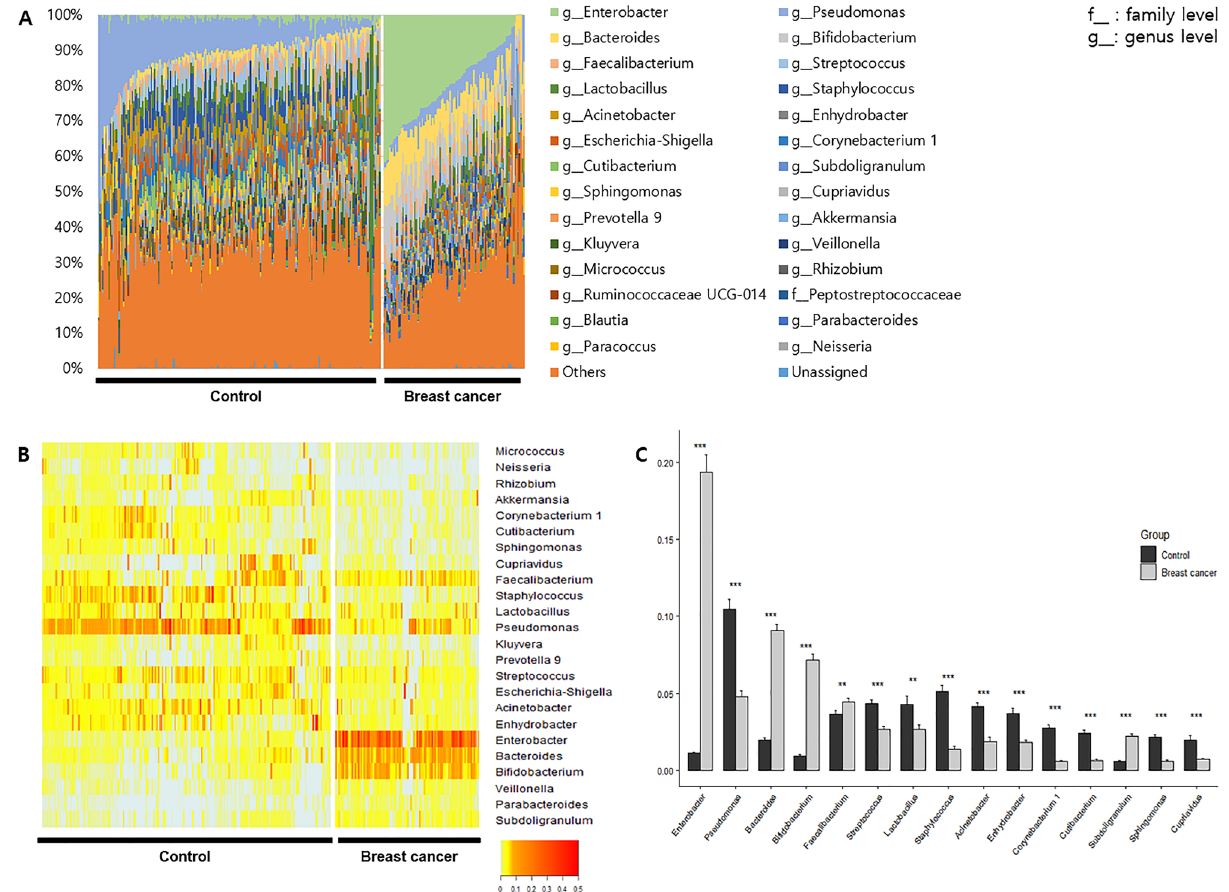
Figure 3. Metagenome profiles in serum of patients with breast cancer and healthy controls at the genus level. ( A ) Abundance of microbiome, ( B ) heatmap of taxa that > 1% of the average abundance in any group, ( C ) significantly different